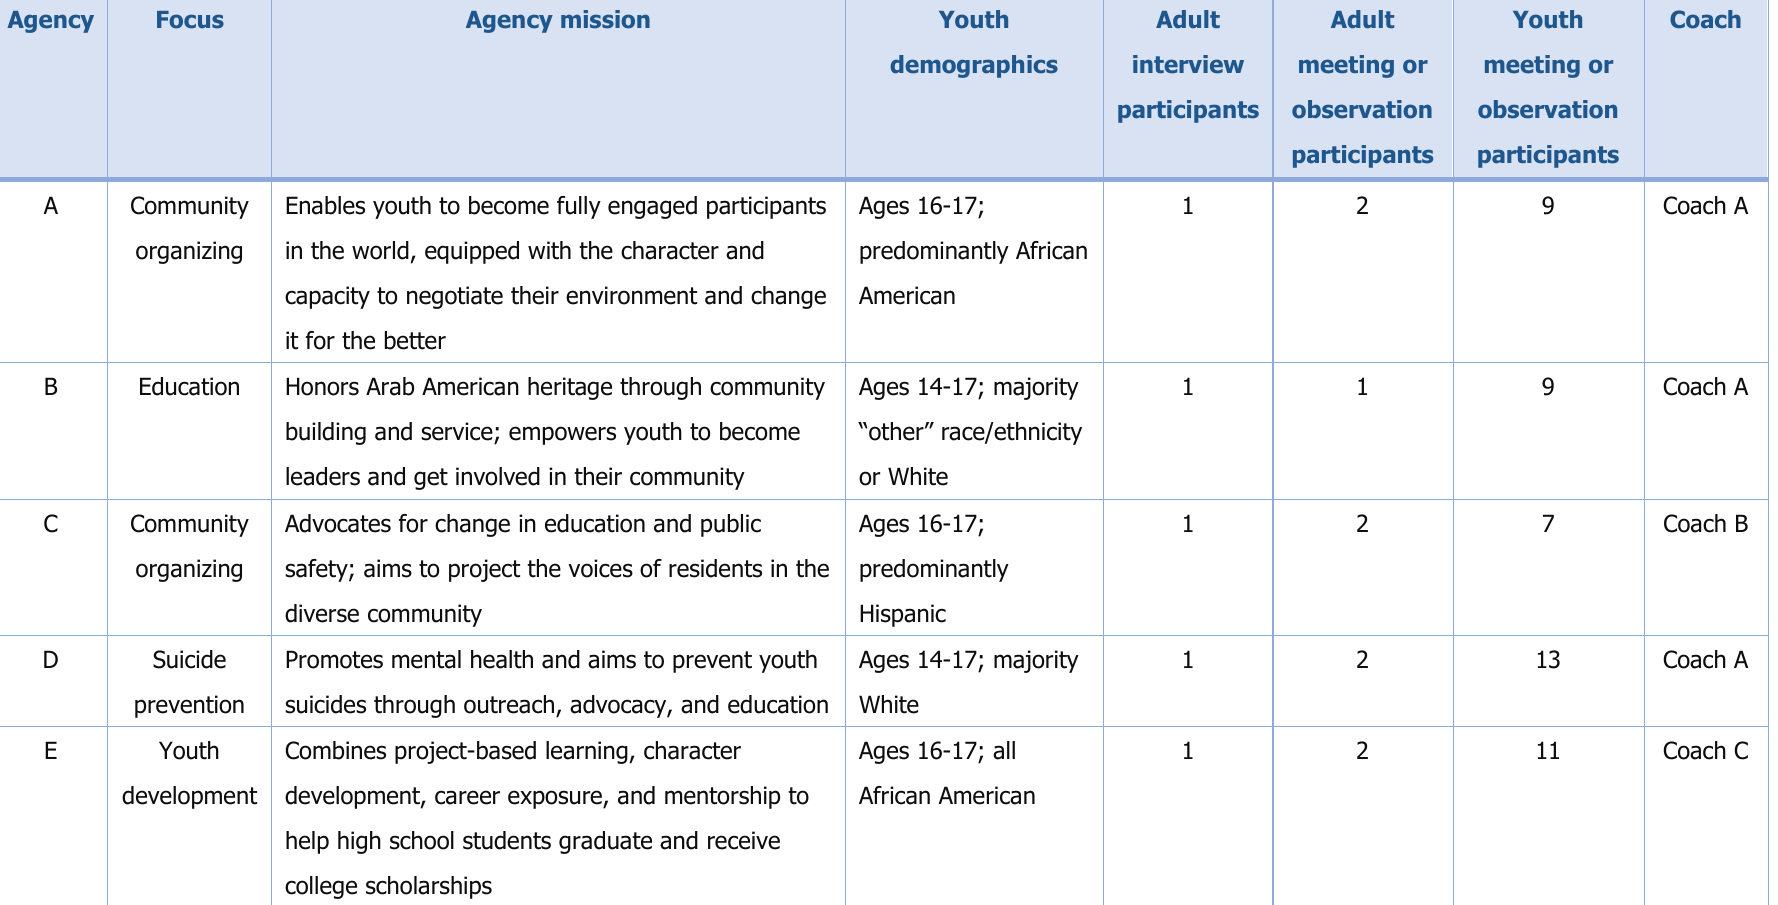
Table 1. Agency Characteristics, Youth Demographics, and Study Participants